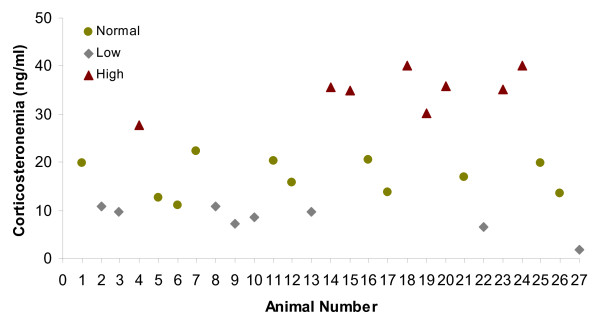
Plasma corticosterone pattern in ACTH treated chickens.